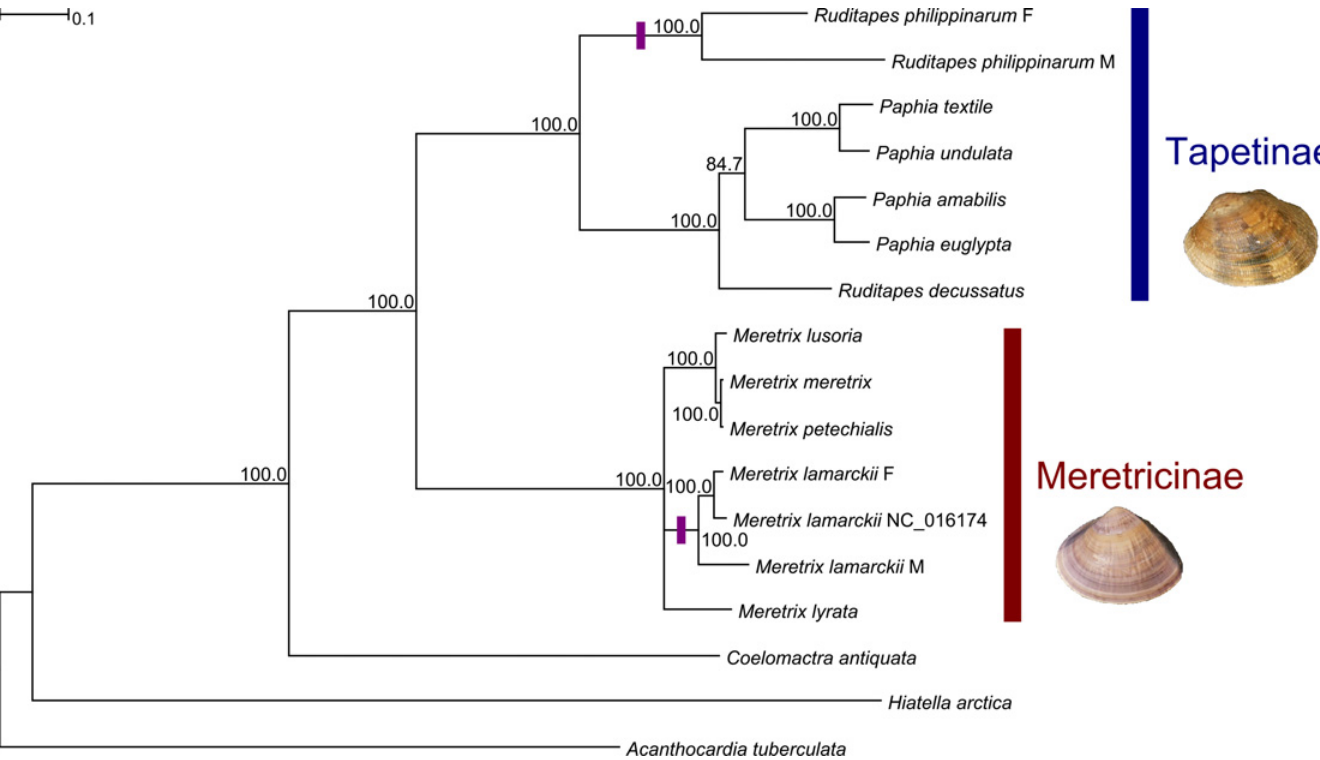
Fig 4. Phylogenetic analysis. Maximum Likelihood phylogenetic analysis of the family Veneridae using complete mitochondrial genomes and Acanthocardia tuberculata (Cardiidae), Hiatella arctica (Hiatellidae), and Coelomactra antiquata (Mactridae) as outgroups. Shown is the consensus of ML trees obtained from 1,000 bootstrap replicates; number at the nodes are bootstrap proportions. Purple bars mark known DUI species.